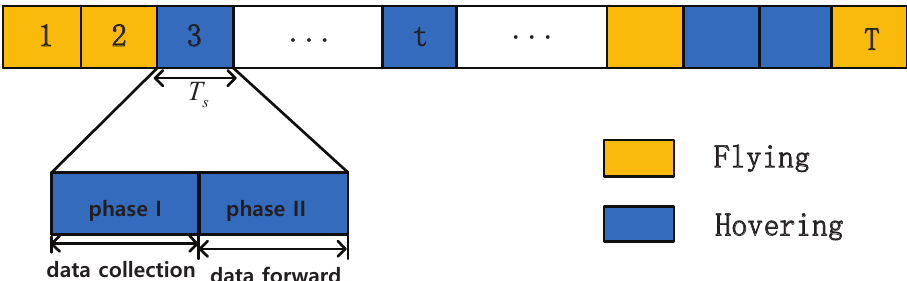
Figure 2. Time structure of transmission